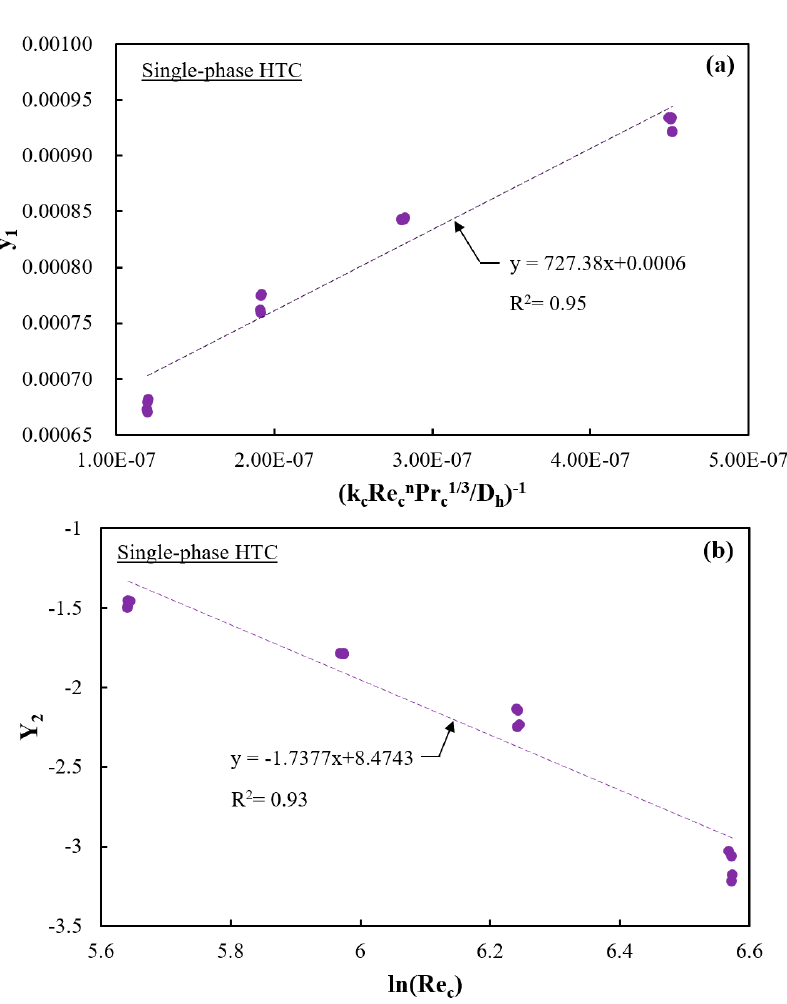
Figure 5. ( a ) and ( b ) Wilson plot charts for deciding water side single-phase convection heat transfer coefficient.